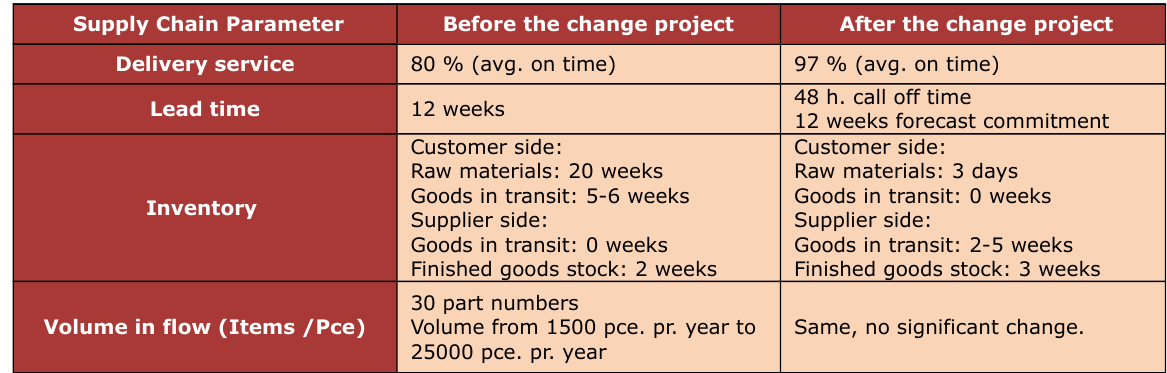
Table 2. Effects of the VMI project on supply chain